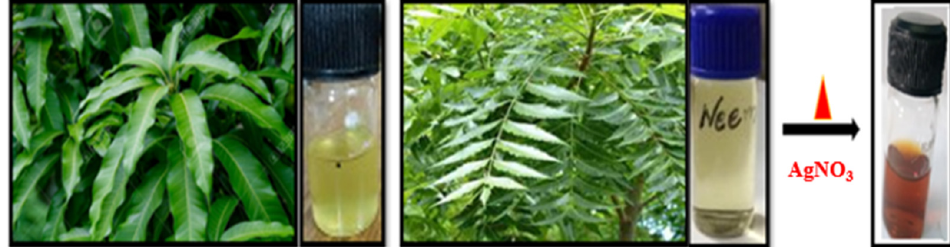
Figure 1. Synthesis of silver nanoparticles using different plants ( A. indica and M. indica ).